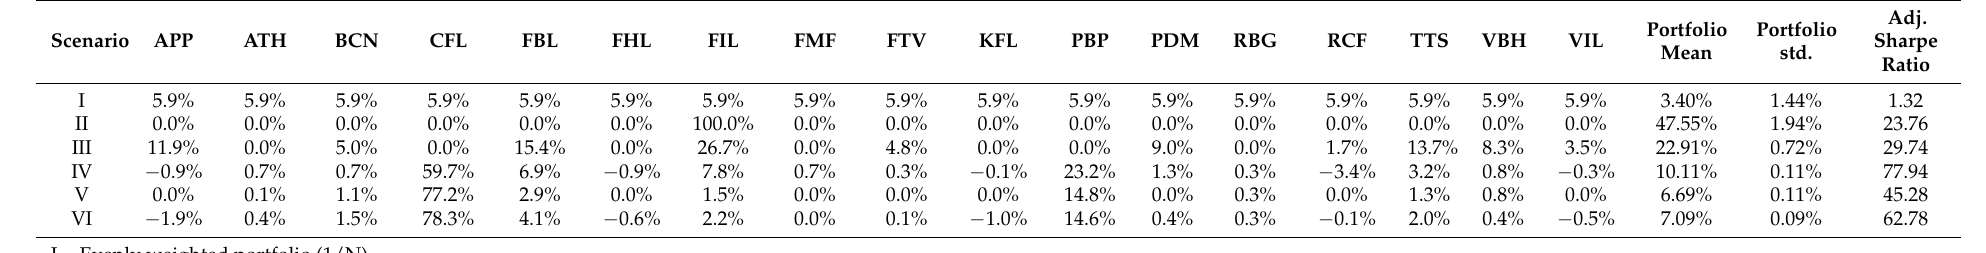
Table 17. Portfolio Weights Based on Different Scenarios with